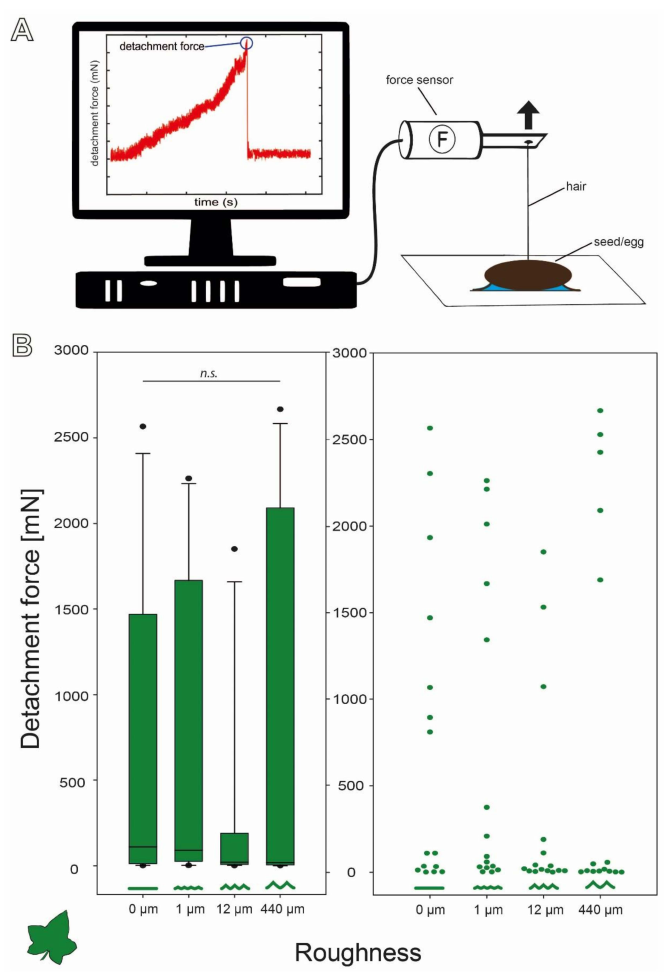
Figure 3. Detachment force measurements. ( A ) Schematic of the experimental setup with an example force–time curve of the detachment force measurement. ( B ) Detachment forces of C. grandis seeds on substrates with different roughness ( N = 15 per substrate) represented by box plots (left) and jitter plots (right). Boxes indicate the 25th and 75th percentiles, the line represents the median, and the whiskers are the 10th and 90th percentiles. n.s . = no statistical difference p = 0.55; Kruskal–Wallis ANOVA on